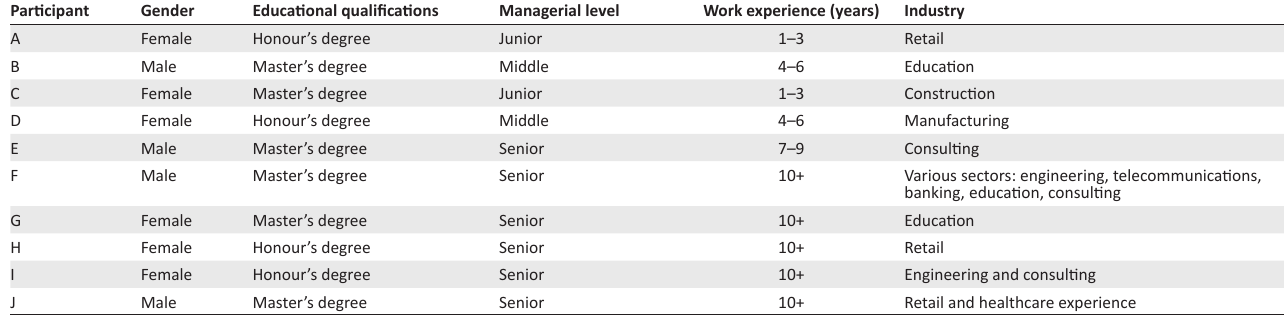
TABLE 1: Demographic profile of human resource professionals as participants.